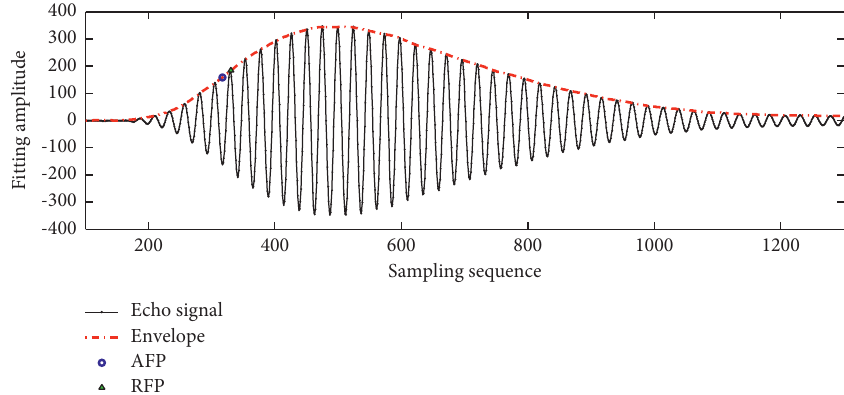
Figure 1: An envelope of echo and the corresponding locations of AFP and RFP.